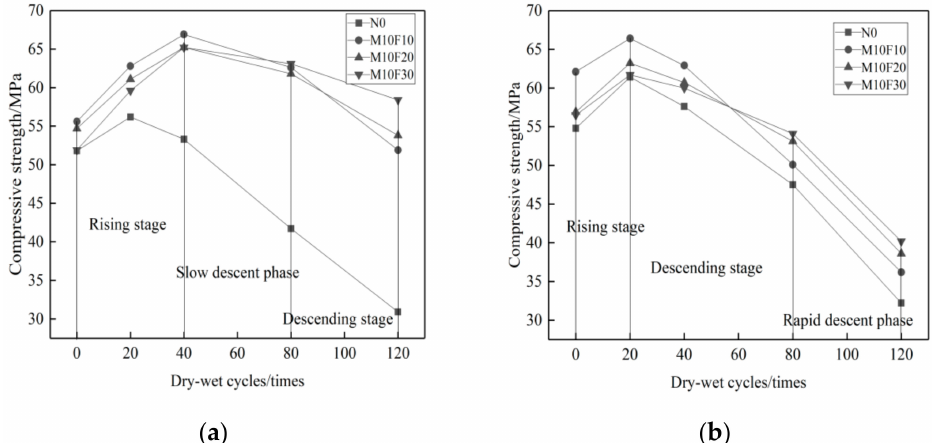
Figure 11. Variation curve of compressive strength of double admixtures concrete with different erosion times under different erosion conditions. ( a ) 10% Na 2 SO 4 , ( b ) 10% MgSO 4 .